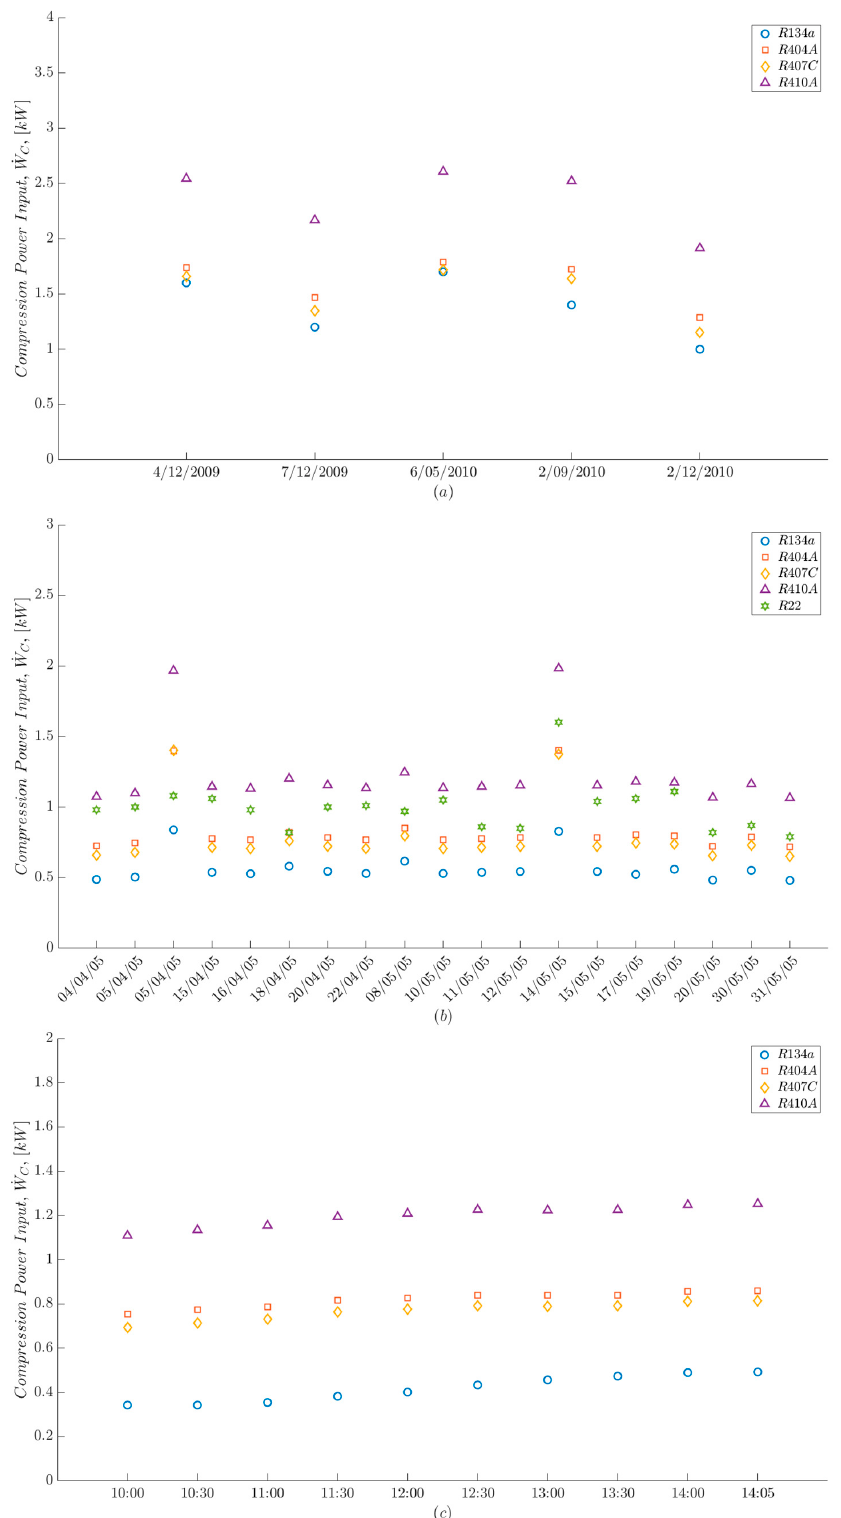
Figure 10. Work compression input of the system with different refrigerants based on the optimization output ( a ) Madrid, ( b ) Shanghai, ( c ) Zagreb.